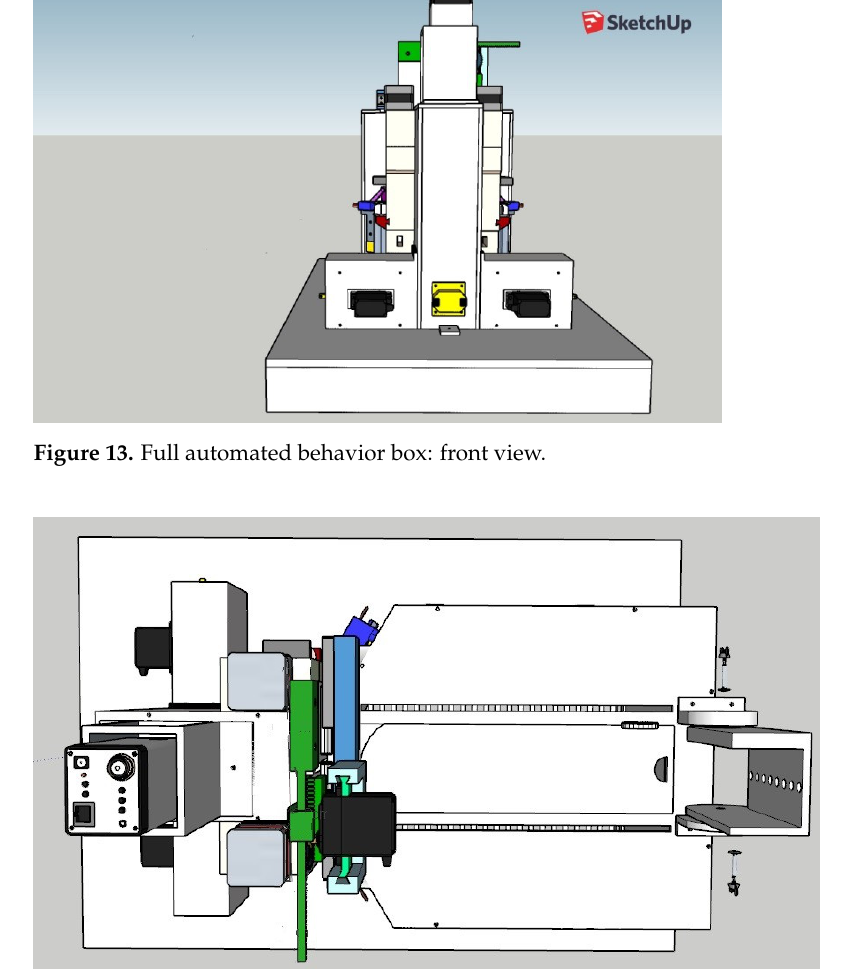
Figure 14. Full automated behavior box: top